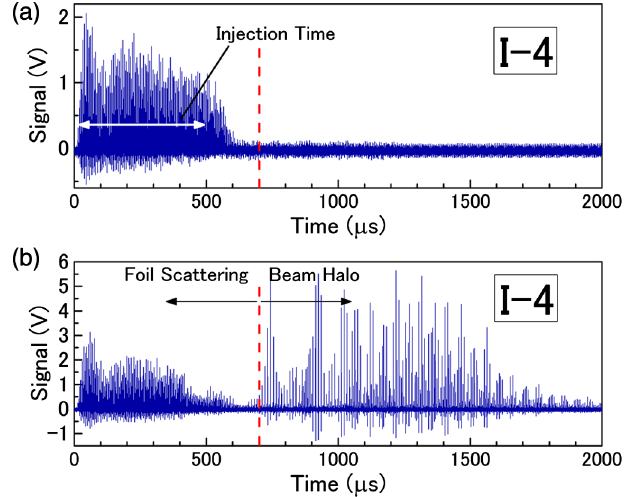
FIG. 10. A typical BLM signal during the injection period. The horizontal axis represents time, and the vertical axis represents the signal amplitude: (a) inside and outside absorbers retracted; (b) outside absorber inserted too far.